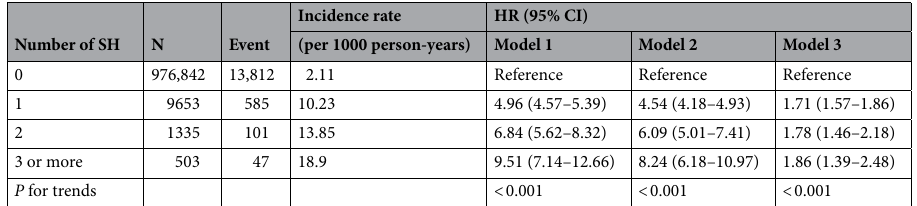
Table 2. Crude and adjusted HRs of end-stage renal disease. Model 1: Unadjusted. Model 2: Adjusted for age, sex. Model 3: Model 2+ smoking, alcohol consumption, regular exercise, living place (urban or rural), income